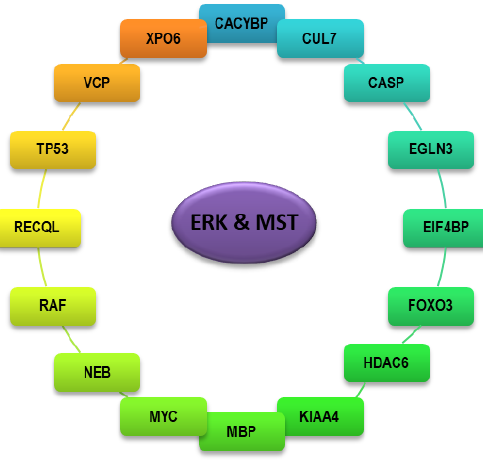
Figure 2. Protein interactors shared between ERK and MST kinase.